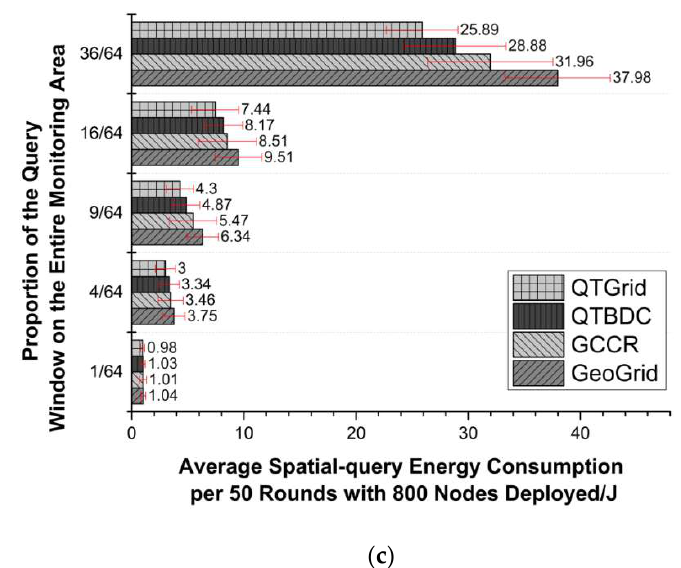
Figure 10. The comparison of spatial query energy consumption. ( a ) Network with 200 nodes; ( b ) network with 400 nodes; ( c ) network with 800 nodes.